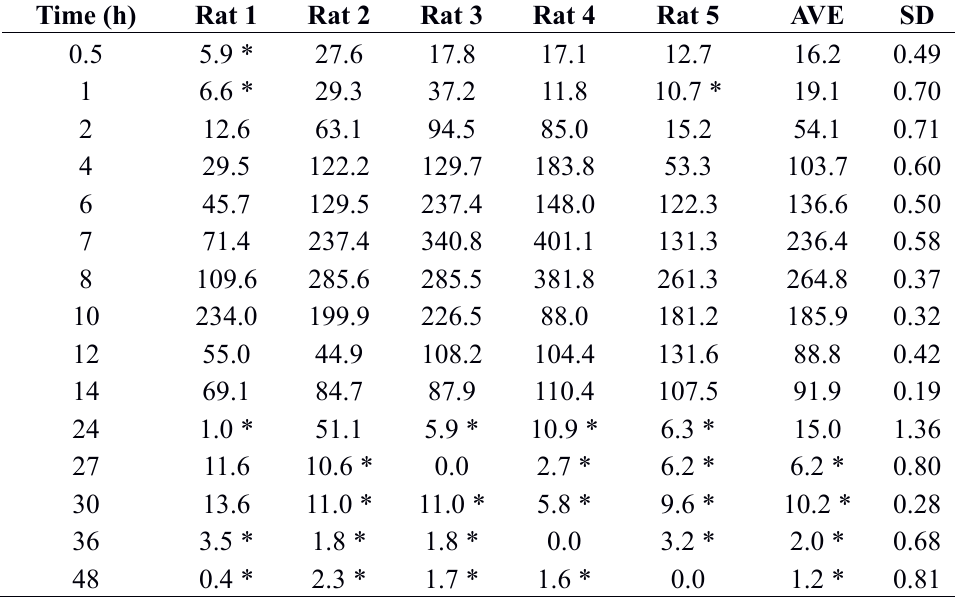
Table 14. Concentration time of TA-III after intragastrical administration to rats at a dose of 50 mg/kg (ng/mL).